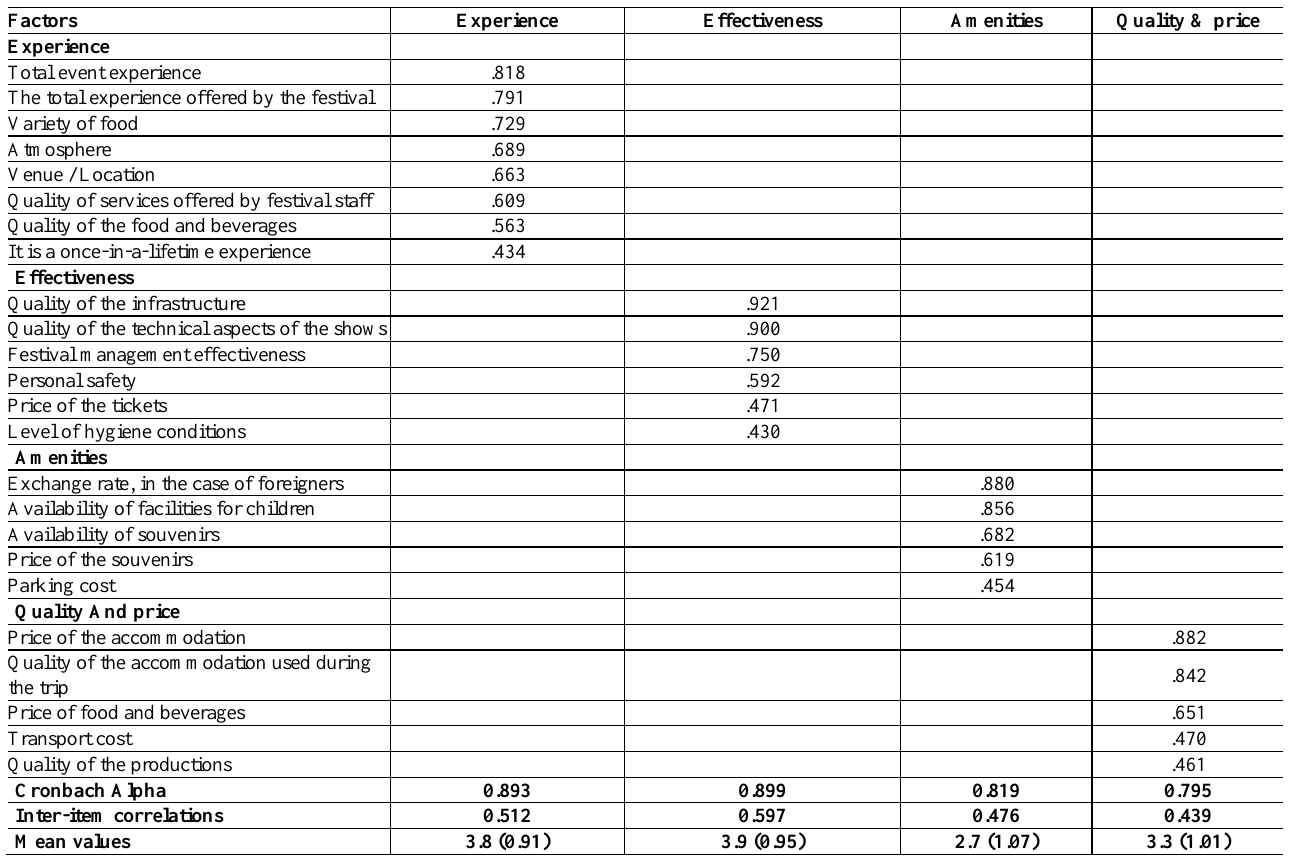
Table 3: Value for money factors